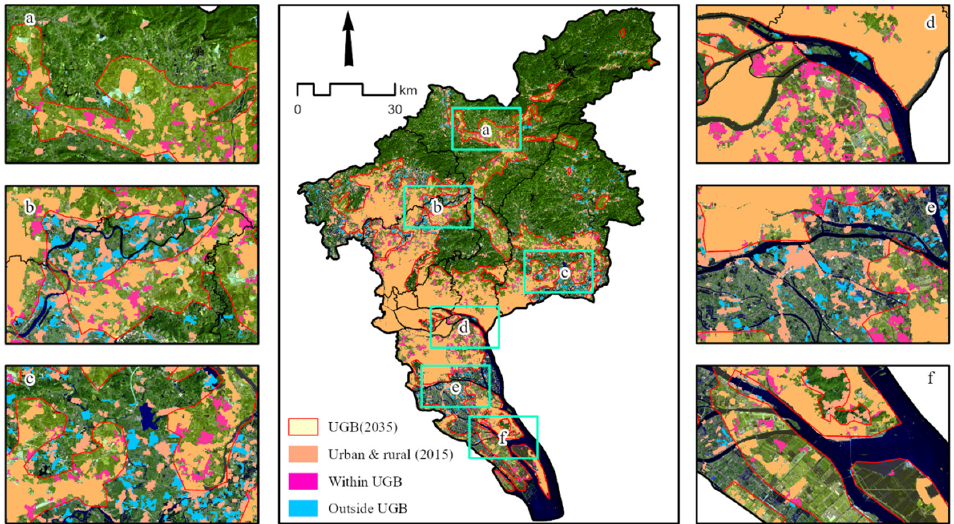
Figure 7. Analysis of the relationship between UGB and the cells simulated with Patch-CA but not observed with remote sensing images.